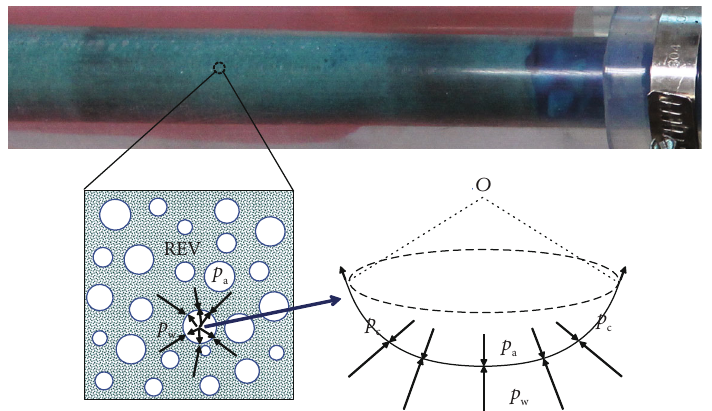
Figure 8: Schematic of air bubble in pores when a point approaches the saturated state, and the corresponding surface tension acting on the water-air